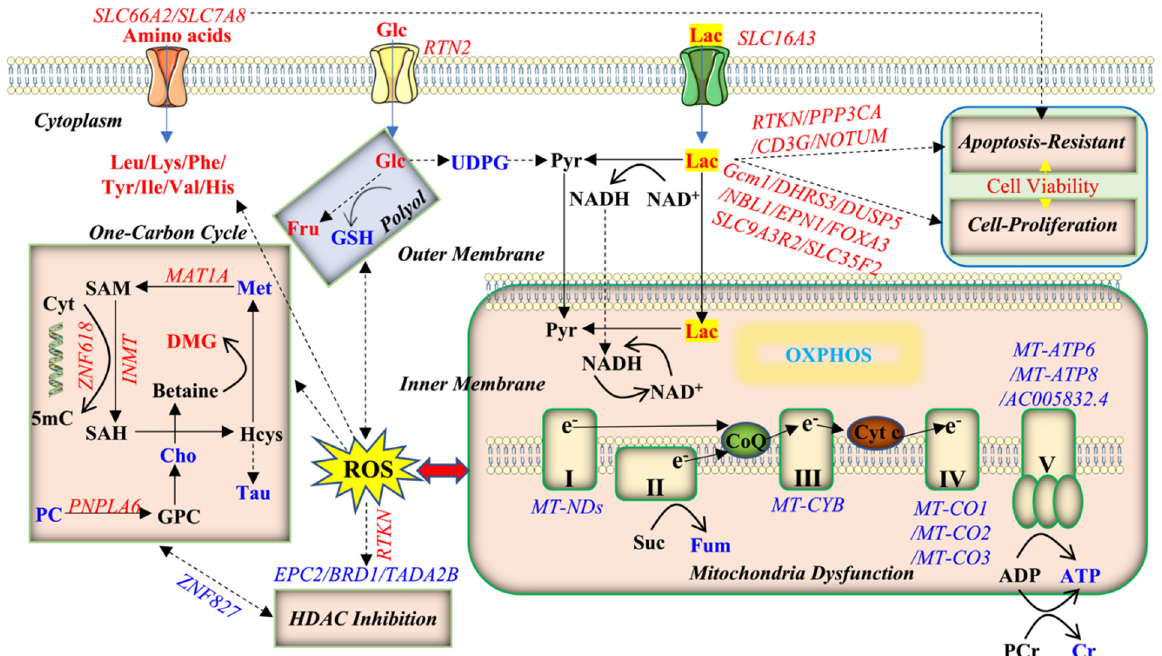
Figure 7. Metabolic and transcriptomic alternations of pathways under lactate exposure. Blue (downregulated) and red (upregulated) in the lactate vs. the control treatments.